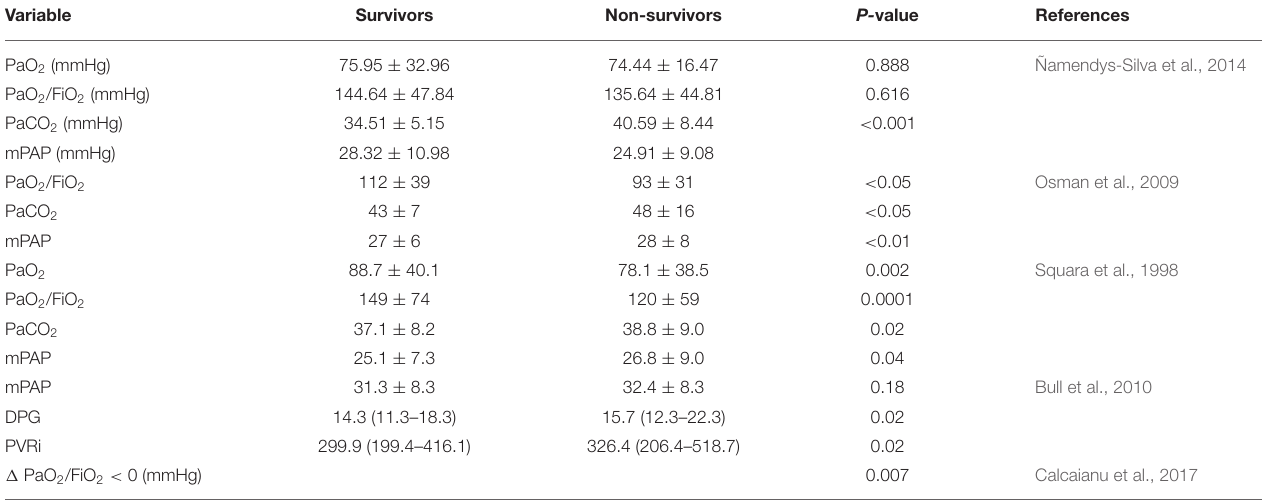
TABLE 2 | Factors associated with mortality of PH in ARDS.